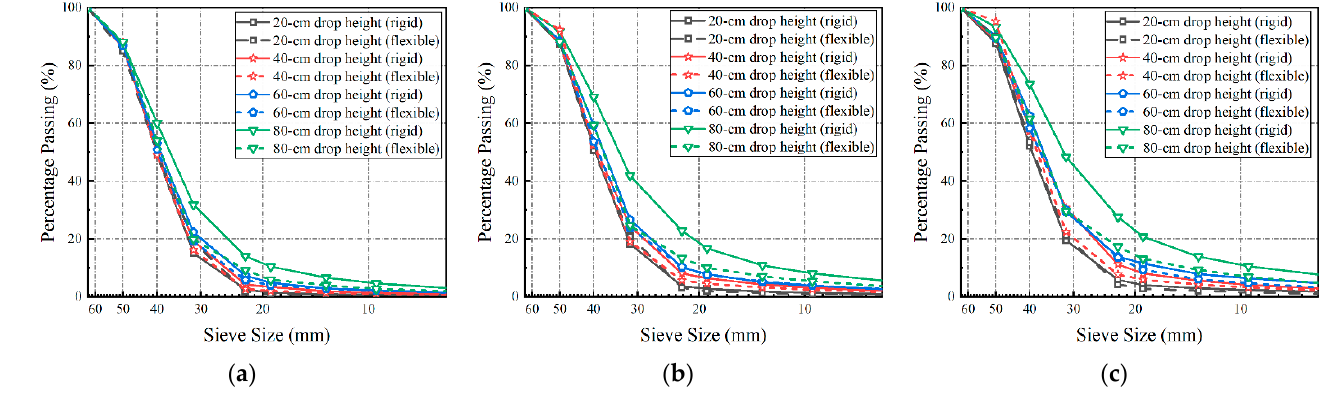
Figure 11. Evolution of the gradation curve of each multiple-size ballast specimen with different numbers of impact-load applications (N): ( a ) N = 20; ( b ) N = 40; ( c ) N = 60.